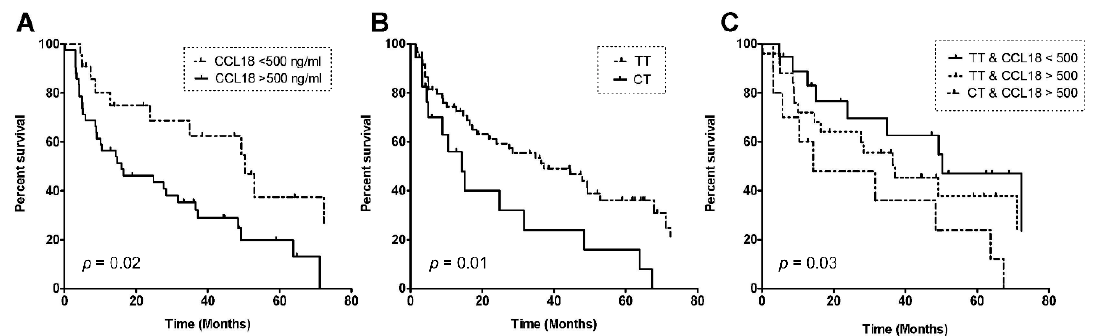
Figure 4. Kaplan–Meier curves for survival in patients with idiopathic pulmonary fibrosis, depending on a serum CCL18 level cut-off of 500 ng/mL ( A ); rs2015086 -genotype ( B ), and a combination of CCL18 cut-off and rs2015086 -genotype ( C ). P-values were calculated via the Log Rank Test using Kaplan–Meier curves.